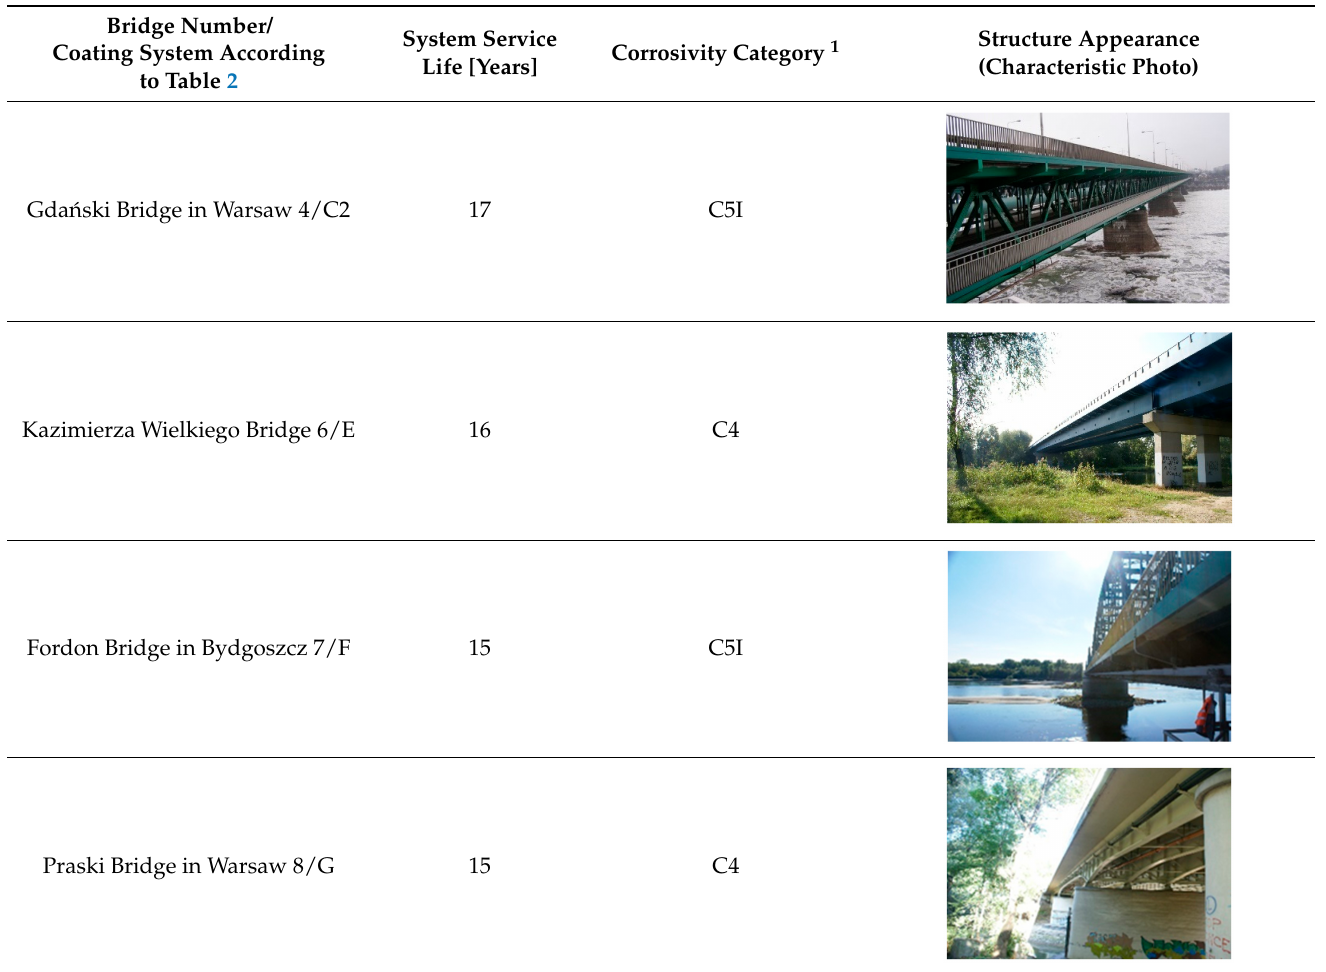
Table 2. All coatings are commercial products of large companies on the market and at the